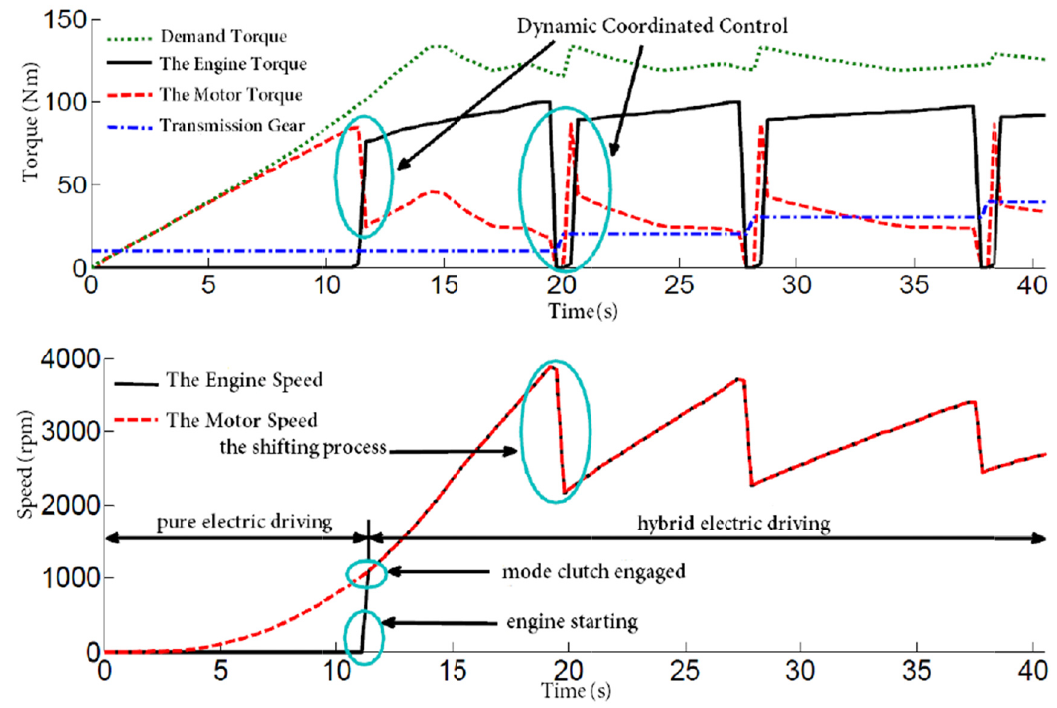
iving ycle odelTarget speed river